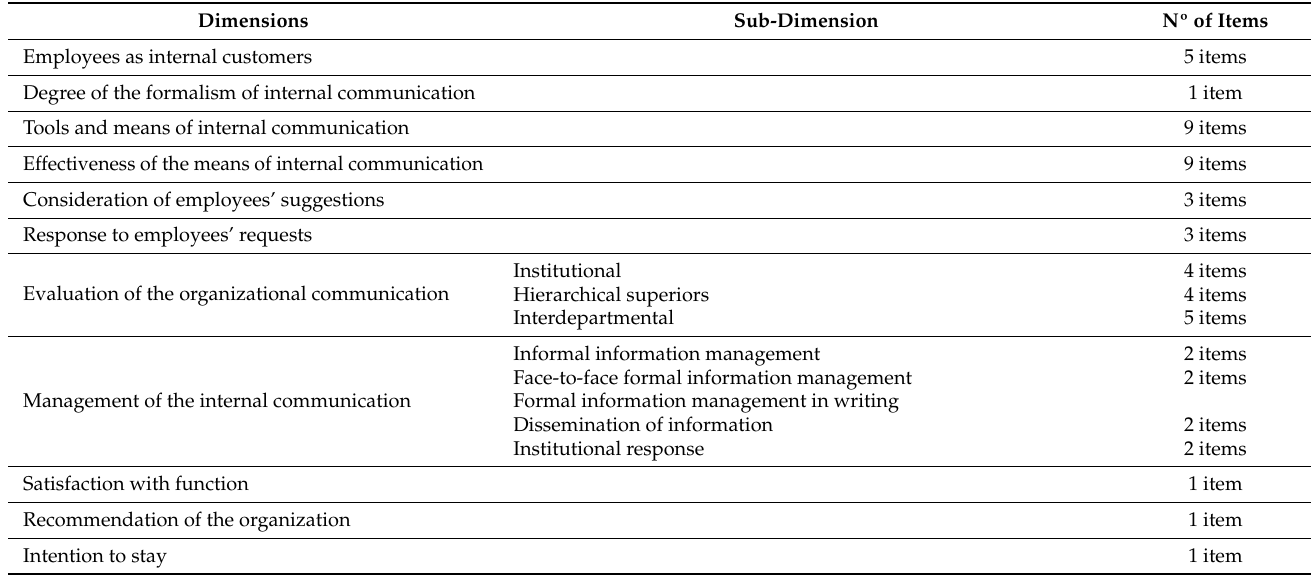
Table 1. Dimensions, categories and items used in the